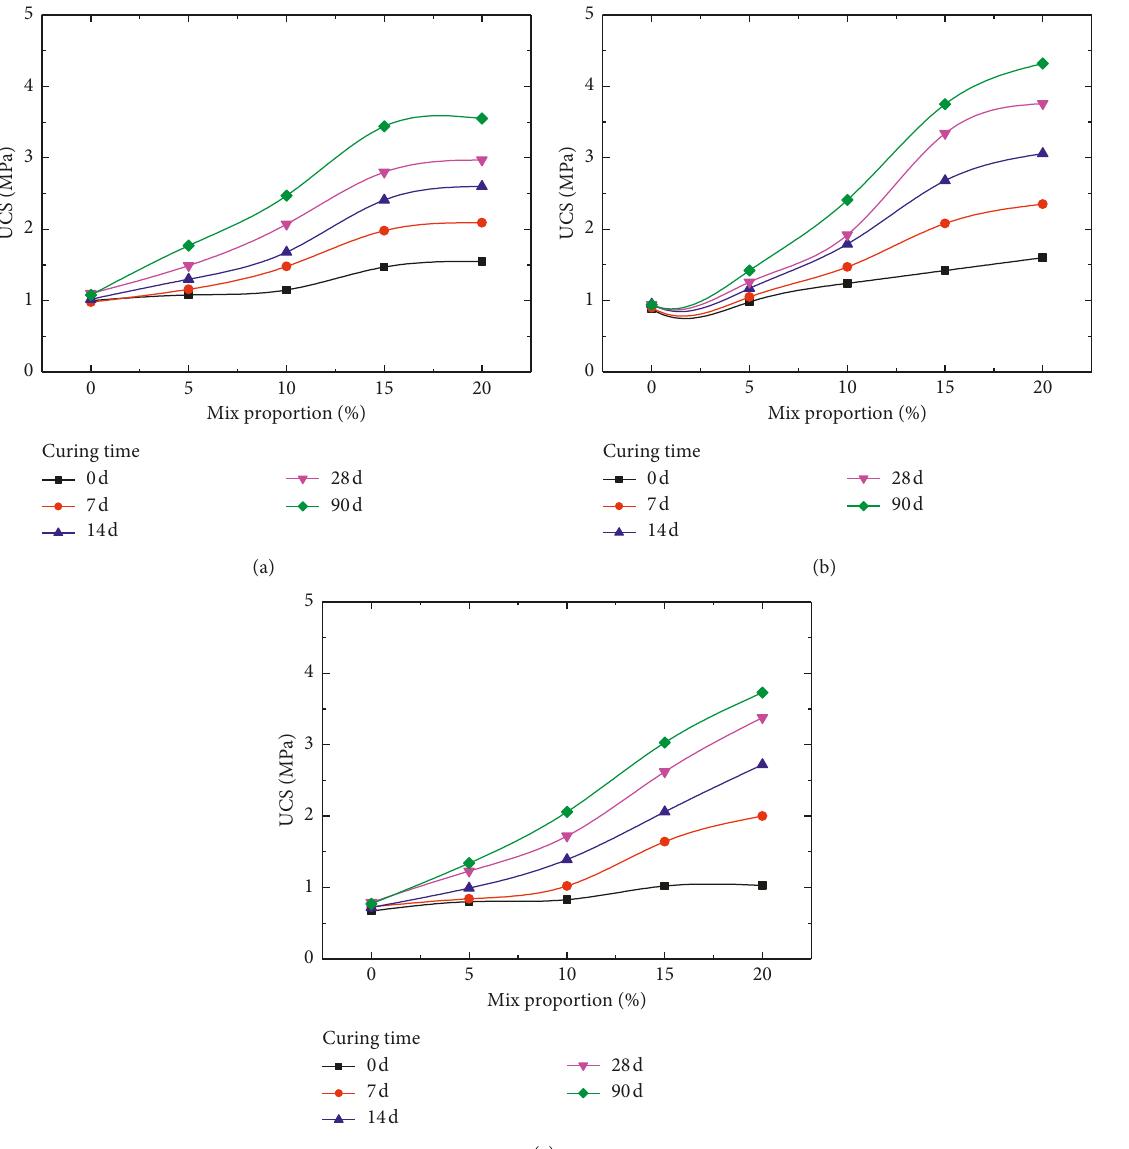
Figure 16: Unconfined compression strength of expansive soil stabilized by RHA-lime. (a) w